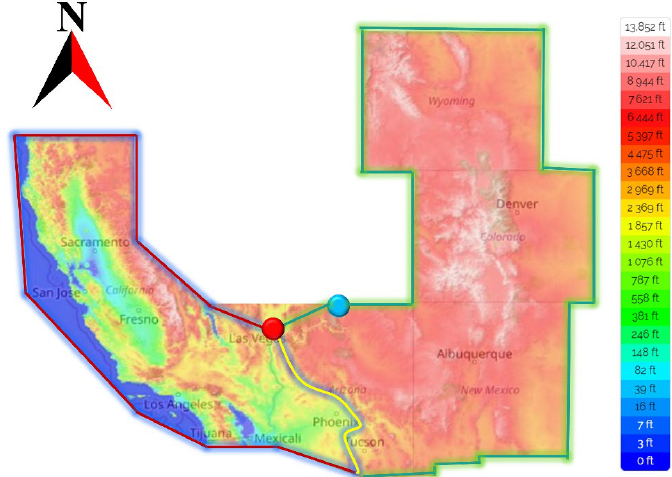
Figure 10. Schematic of distribution under extreme conditions, idealized state.